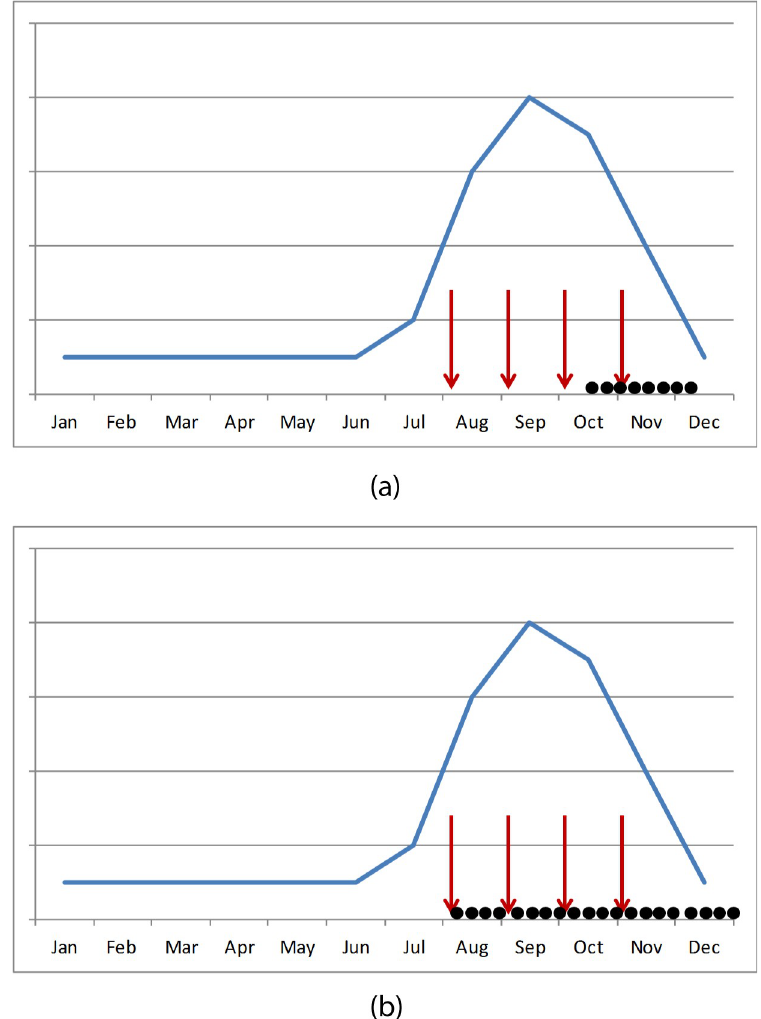
Fig 1. Schematic of recruitment of cases and controls in 2015 and 2016. (a) 2015; (b) 2016. This schematic of recruitment shows the timing of seasonal malaria chemoprevention (SMC) cycles (red arrows) and the recruitment period of the case–control study (black dots) in relation to the typical seasonal peak in malaria cases (hypothetical seasonality pattern shown by the blue line). In 2015, cases and corresponding controls were recruited in the late rainy season and early dry season in Mali and The Gambia. In 2016, cases and controls were recruited uniformly across the entire malaria transmission season in Burkina Faso, Chad, Mali, Nigeria, and The Gambia, from the time of the first SMC cycle until 8 weeks after the final